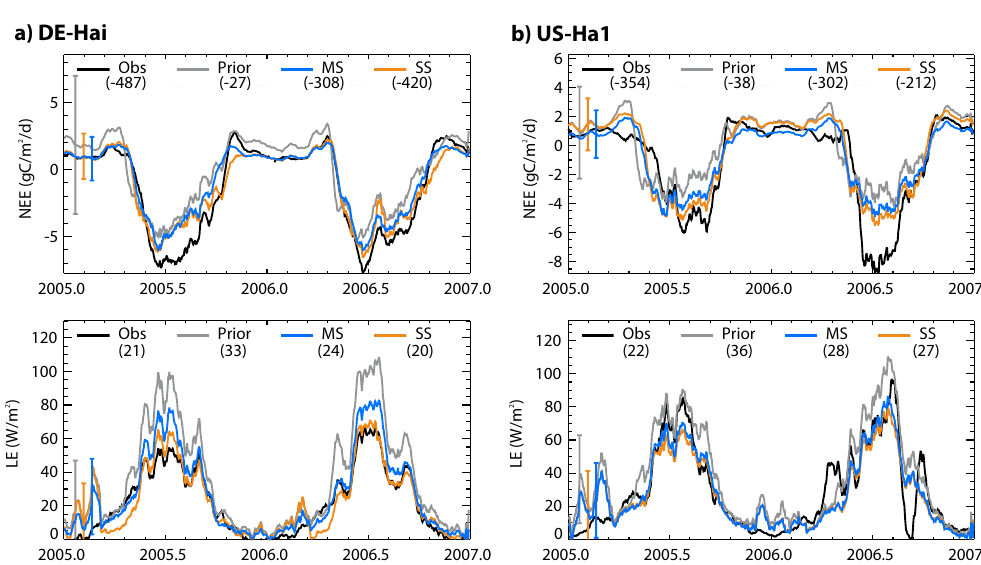
Fig. 2. Seasonal cycle of NEE and LE at (a) Hainich and (b) Harvard Forest sites, smoothed with a 15-day moving average window. The observations (black) are compared with the prior model (grey), the MS optimization (blue) and the SS optimization (orange). The error bars give the total flux uncertainties. The annual carbon budget (gCm − 2 yr − 1 ) and the annually averaged LE flux (Wm − 2 ) are given between